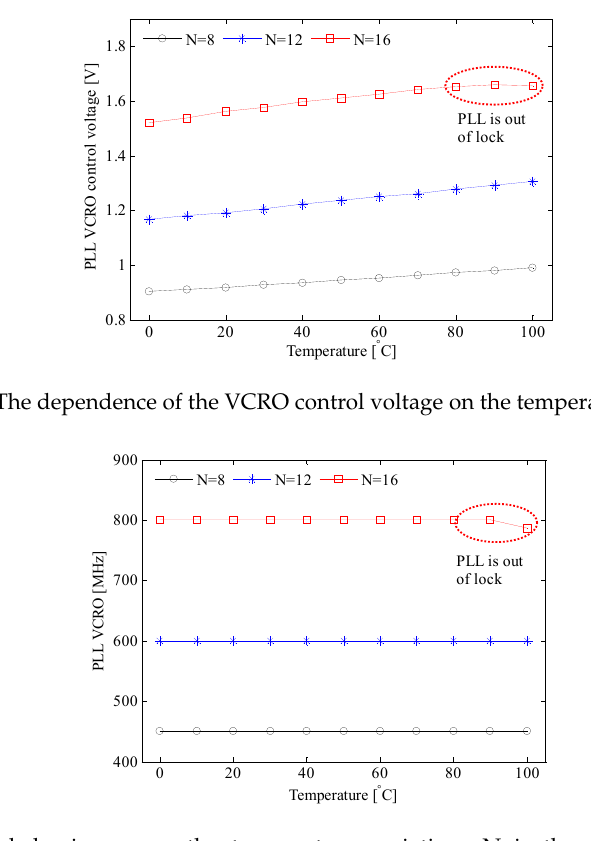
Figure 10. PLL behavior across the temperature variation; N is the division factor of the frequency divider.